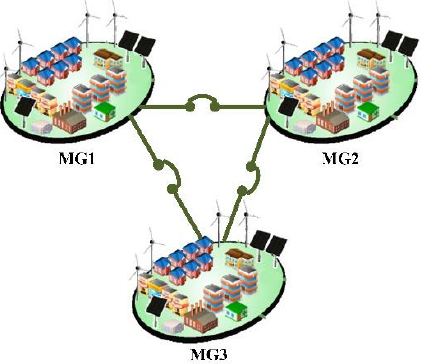
Figure 1. NMG consists of three residential MG and one industrial MG.